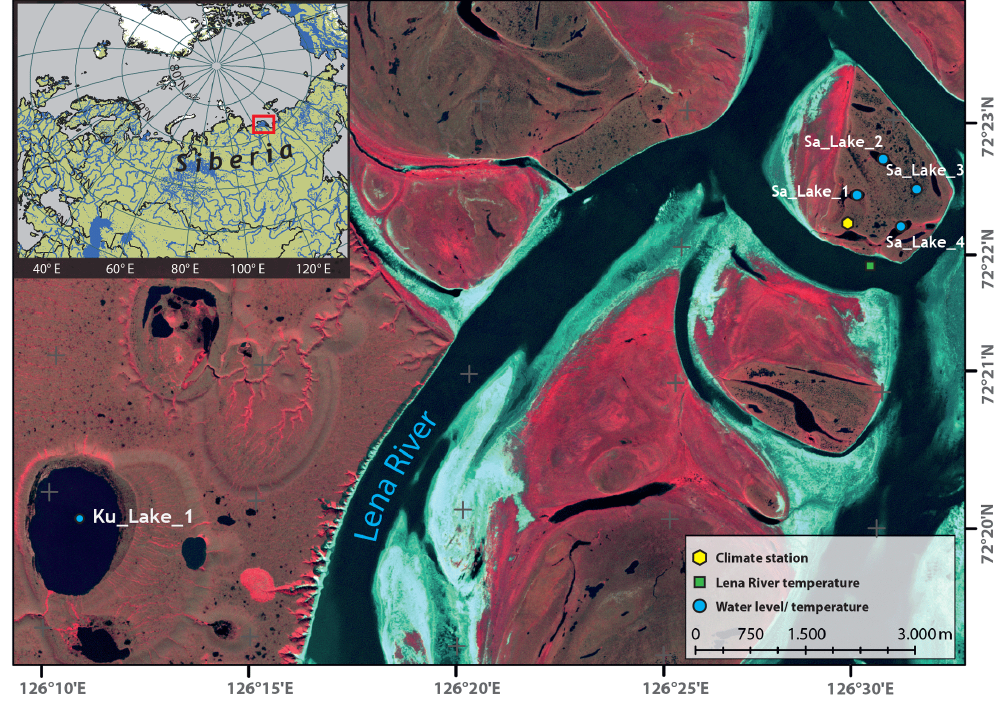
Figure 1. Location of the study sites in the Lena River Delta of eastern Siberia; sites are within the zone of continuous permafrost on the islands of Kurungnakh (Ku_Lake_1), and Samoylov (Sa_Lakes_1-4). The inset map shows the location of the Lena River Delta in northern Eurasia and the distribution of lakes (Global lakes and wetland map; Lehner and Döll,